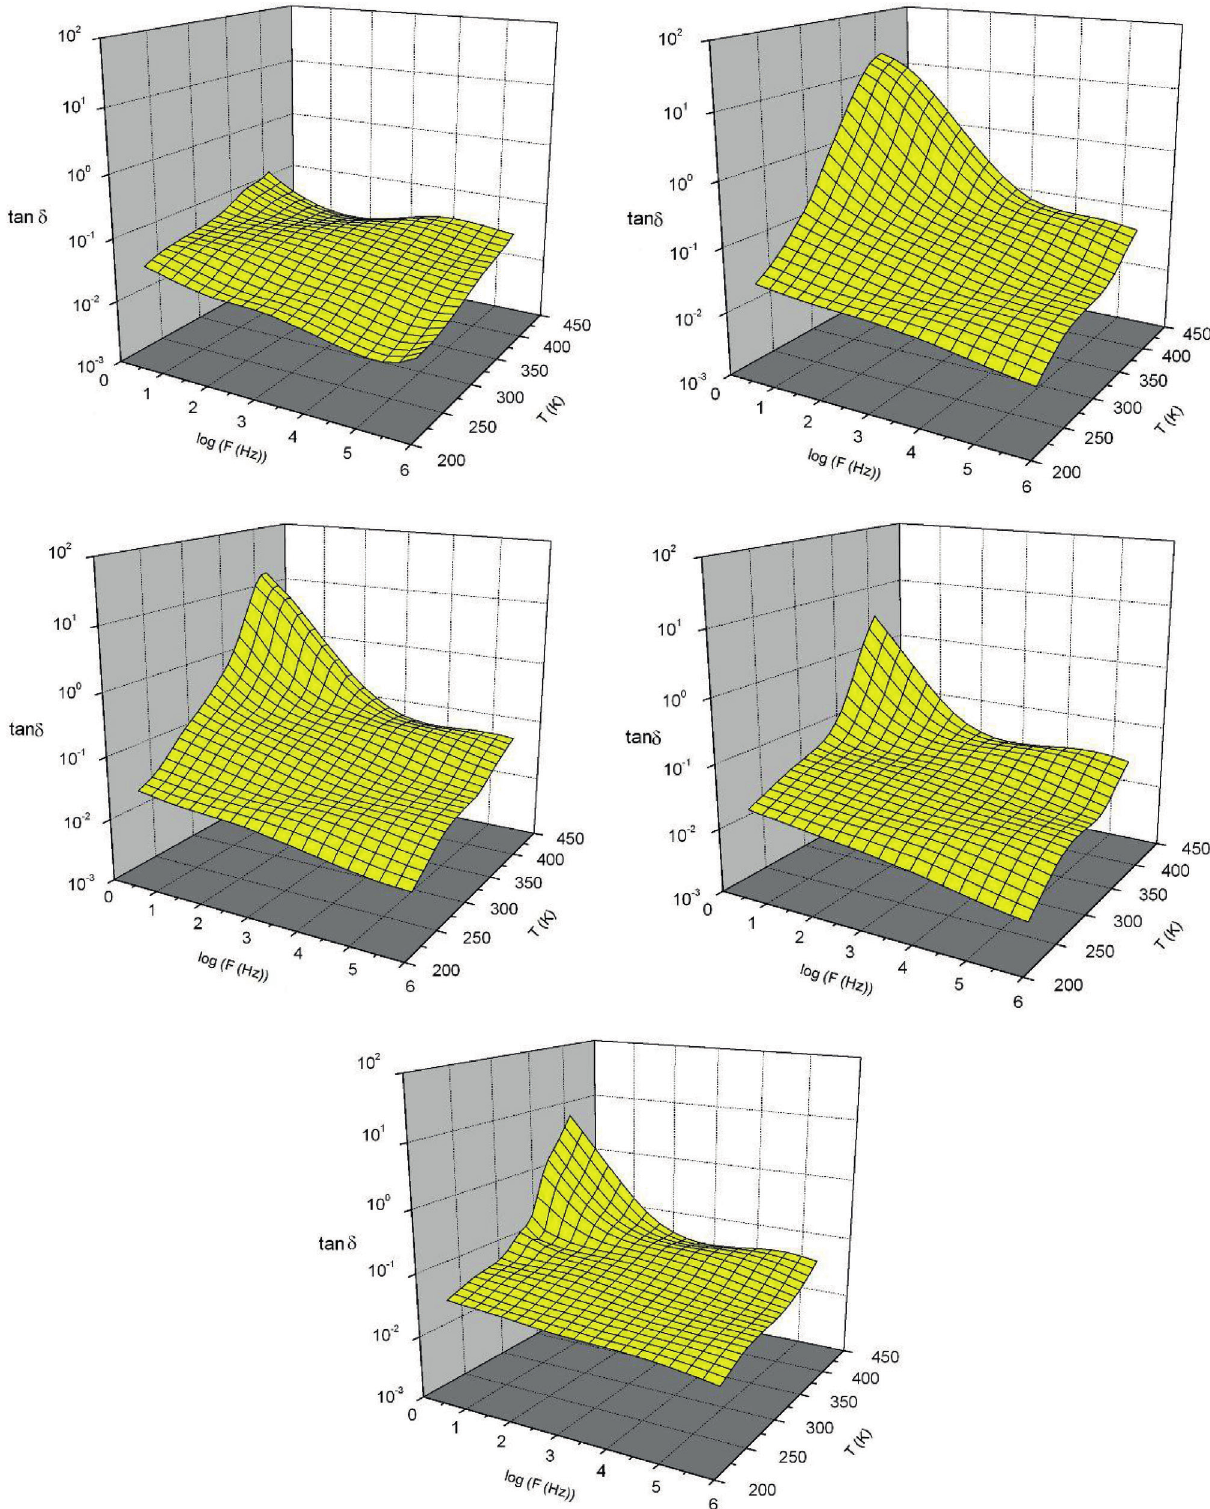
Fig. 2: The variation of tan δ with frequency and temperature for the samples x = 0, 0.25, 0.50, 0.75, 1.00 respectively from top to